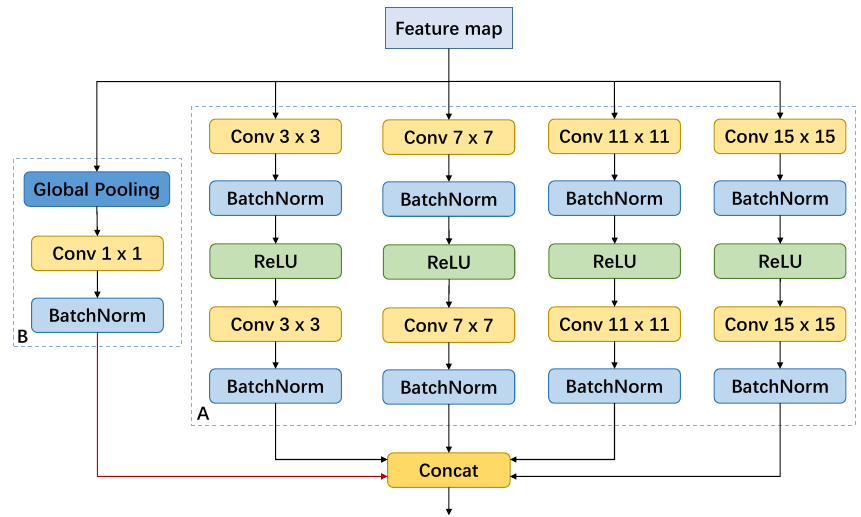
Figure 2. Context Fuse Module structure. Part A is a parallel convolutional block. Part B is a global pooling branch. Red line represents bilinear upsample